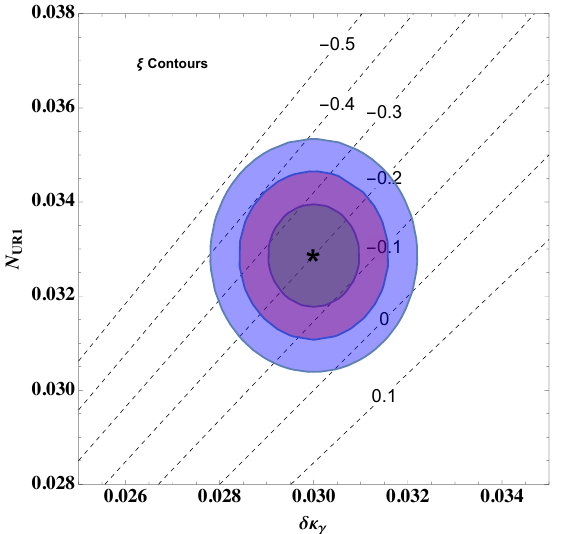
Figure 6. The expected 1,2,3 (cid:27) measurement on the UR1 by using (cid:14)(cid:20) (cid:13) = 0 : 03 ; (cid:24) = benchmark point (the star point). The dashed lines correspond to the constant values of (cid:24) inferred from